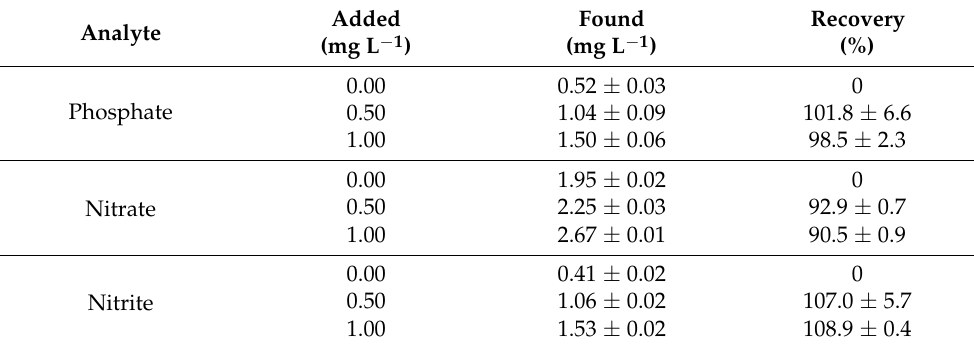
Table 4. Percentage recoveries from spiked real sample (P14), analyzed using in-tube hydrogel test kits and on-mobile DIC.